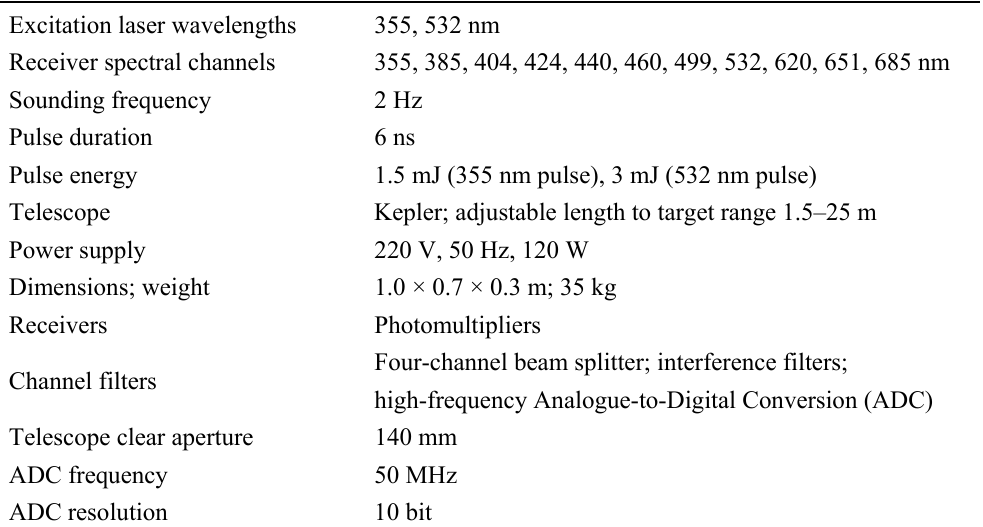
Table 1. Key features of the Ultraviolet Fluorescence LiDAR